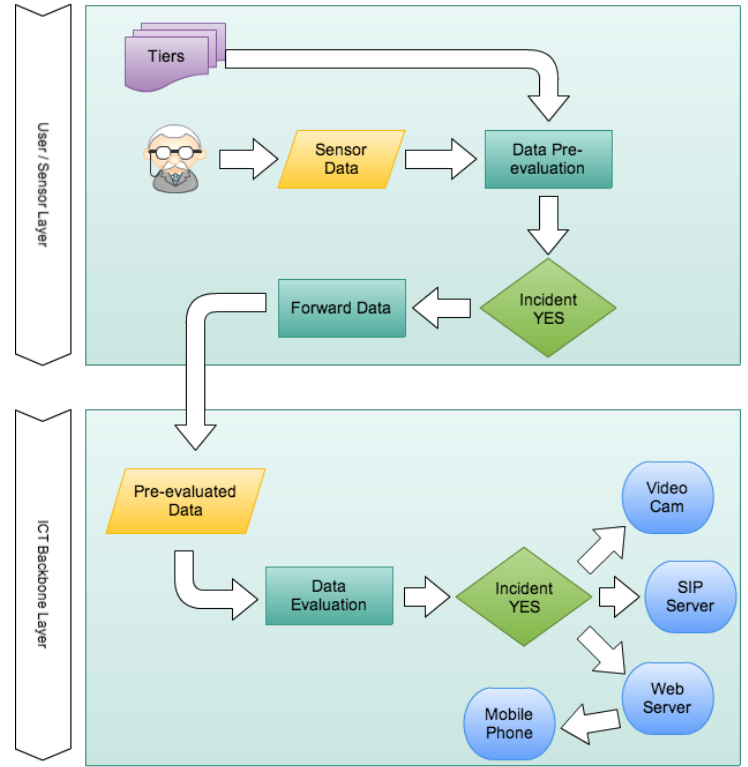
Figure 1. Proposed approach workflow.